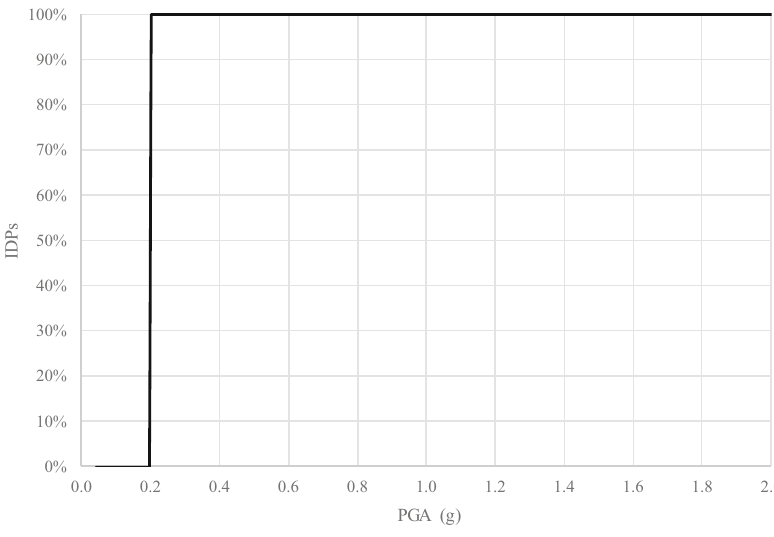
Fig. 1 Binary relationship